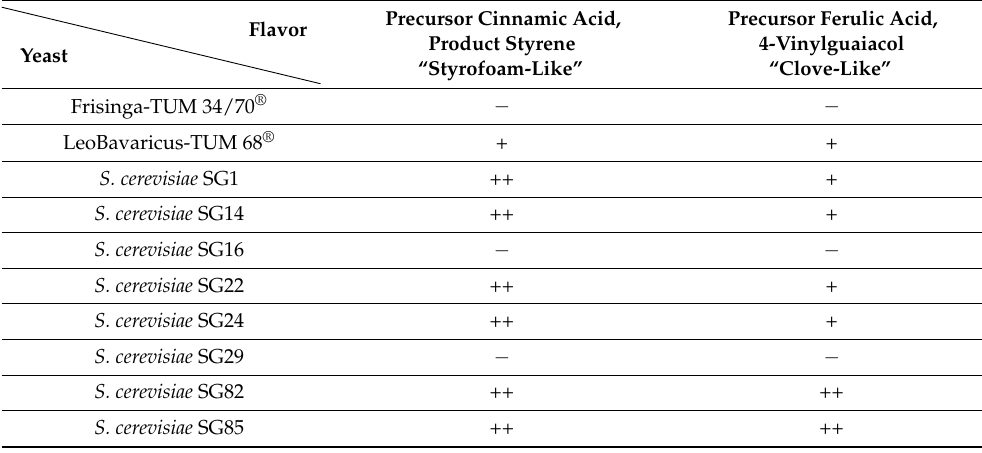
Table 4. Results of the phenolic off-flavor (POF) test performed with eight of the investigated strains